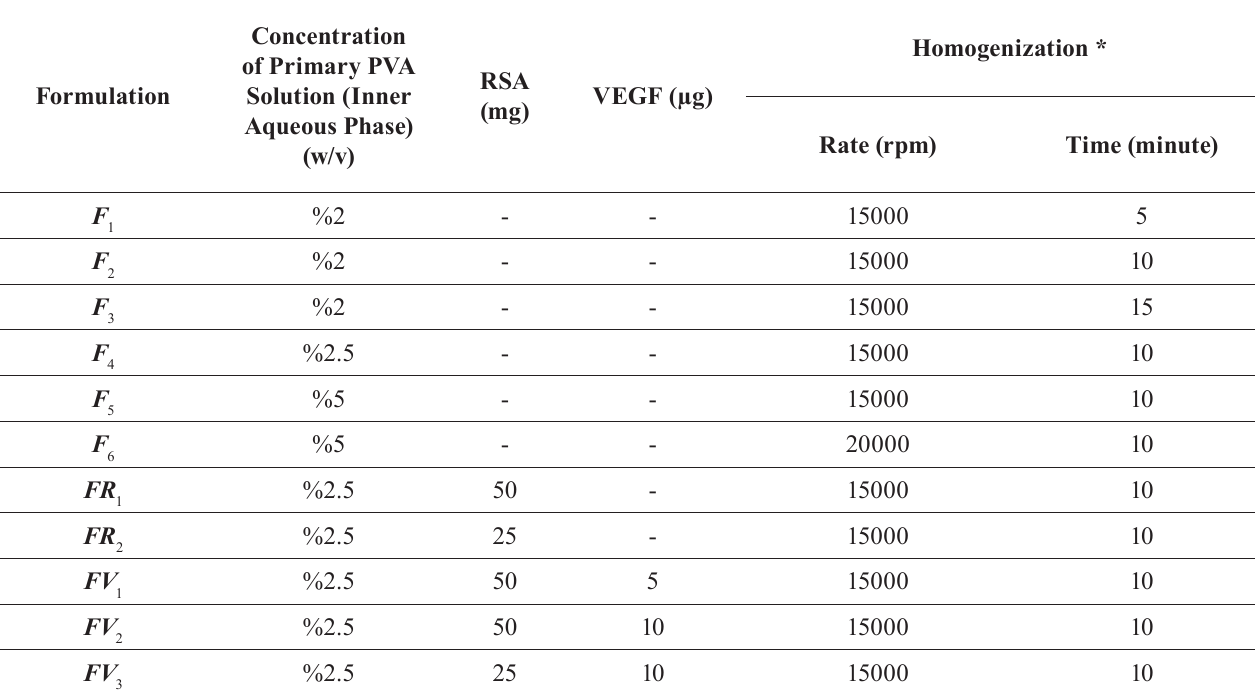
PVA: Polyvinyl alcohol, RSA: Rat serum albumin, VEGF: Vascular endothelial growth factor. *Homogeniser rate and using time during the preparation of secondary water-in-oil-in-water emulsion.